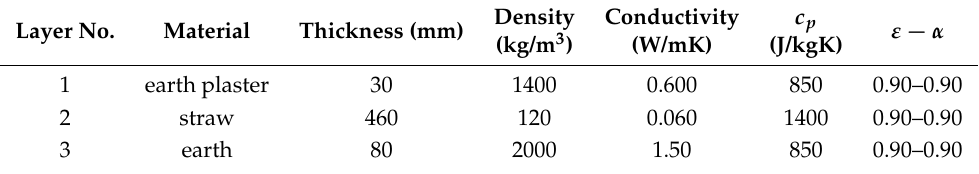
Table A4. Case D: straw bales and earth wall, “STRB” (Layer 1 is outdoors). Thickness: 570 mm. Layer